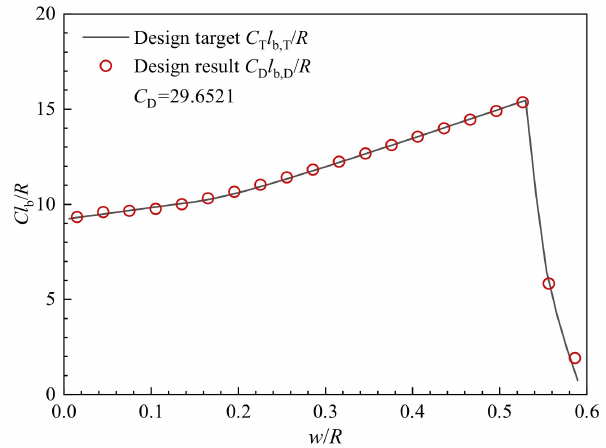
Figure 20. Relation between the dimensionless burn perimeter and dimensionless web thickness of the designed